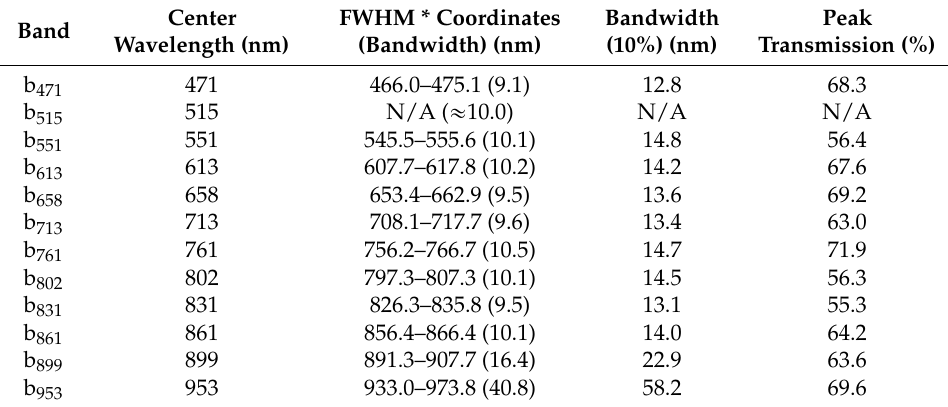
Table 1. Filter configuration of the Mini-MCA 12 and optical properties of the mounted filters. For band 2 (b), no fact sheet has been provided (N/A).